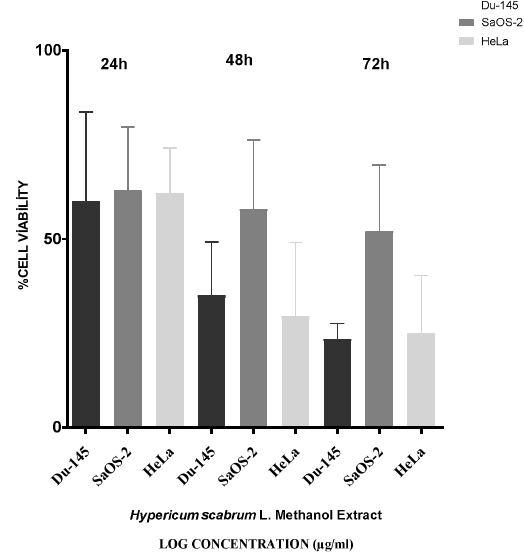
Fig. 1. Cytotoxity activities of methanol extract of Hypericum scabrum L. on Saos-2, HeLa and DU-145 cell